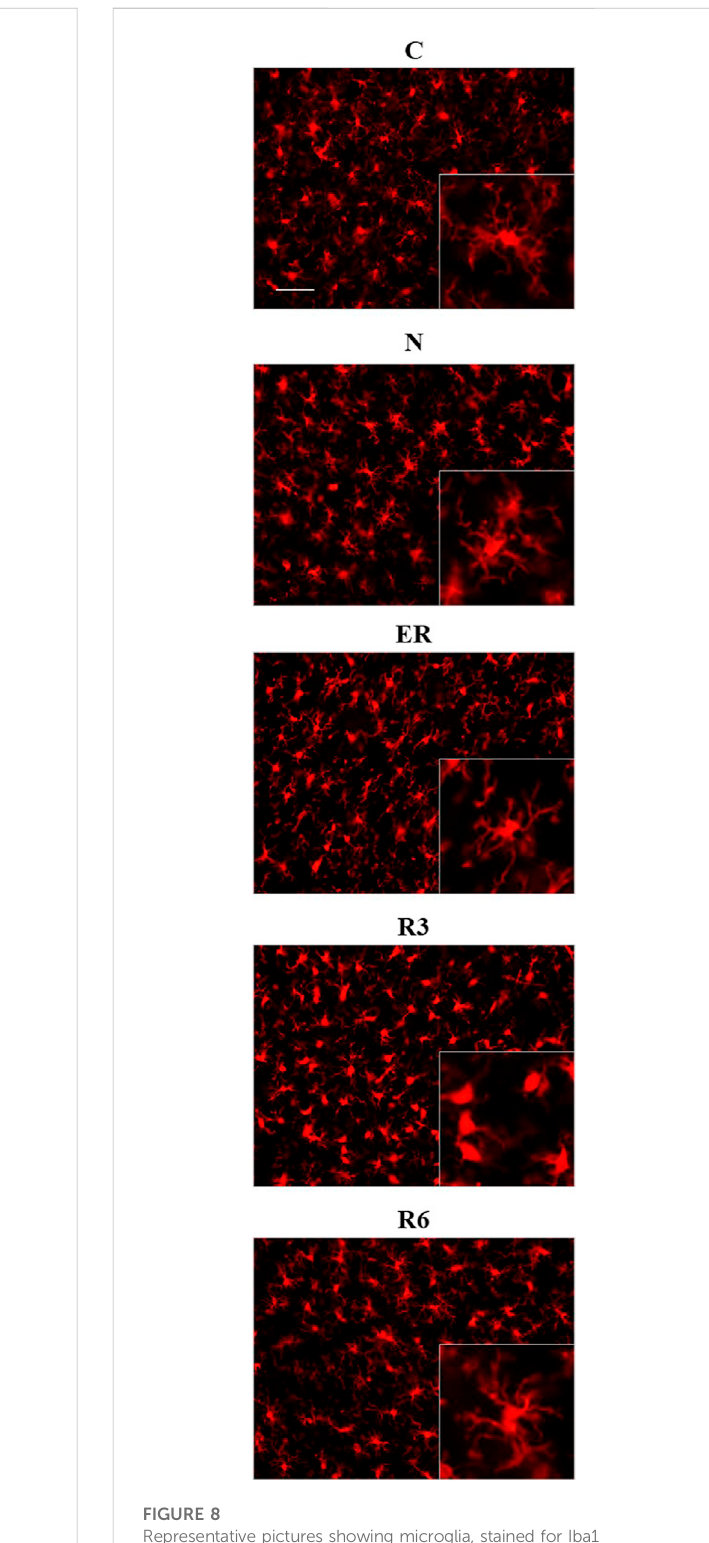
FIGURE 7 Levels of different plasmatic factors. (A) Melatonin; (B) Adrenaline; (C) Noradrenaline; (D) Dopamine; (E) Cortisol; (F) Corticosterone. Data are expressed as means ± S.E.M., n = 4 (see Methods for details). *: p < 0.05 vs. C. Experimental groups (see Figure 1): C, control; N, samples taken at nadir of hypothermia, during ST; ER, early recovery, samples taken when Tb reached 35.5 ° C following ST; R3, samples taken 3 h after ER; R6, samples taken 6 h after ER.